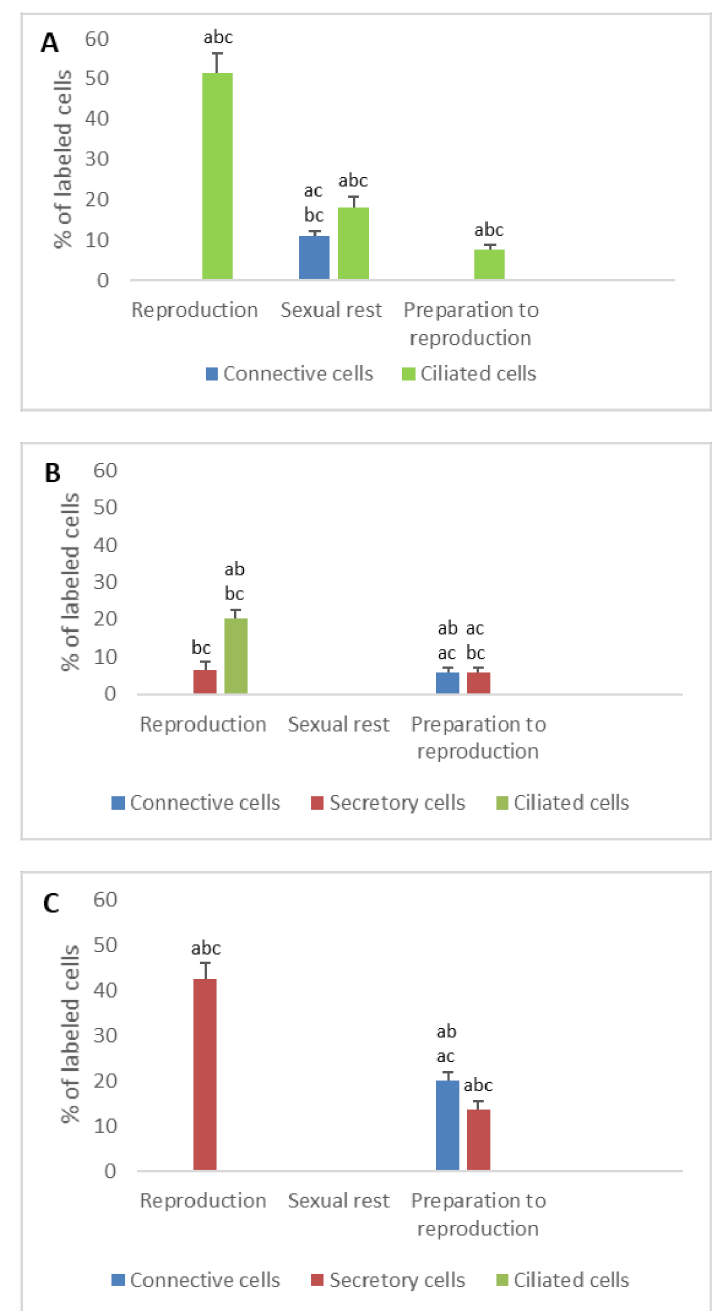
Figure 6. Percentage of LHR immunodetected in the different cell types of the genital tract of Typhlonectes compressicauda before ovulation and during the reproduction period (pregnant females) and sexual rest (quiescent females). Significant differences (ANOVA, α = 0.05) between the 3 groups of females (a: before ovulation; b: pregnant females; c: quiescent females) are reported with the letters a, b, c. ( A ) Ostium (connective cells n = 6, Pr > F: 0.001, ciliated cells n = 6, Pr > F: 0.002); ( B ) Tubal part (connective cells n = 6, Pr > F: 0.005, secretory cells n = 6, Pr > F: 0.031, ciliated cells n = 6, Pr > F: 0.001); ( C ) Uterus (connective cells n = 6, Pr > F: 0.002, secretory cells n = 6, Pr > F: 0.001, ciliated cells n =